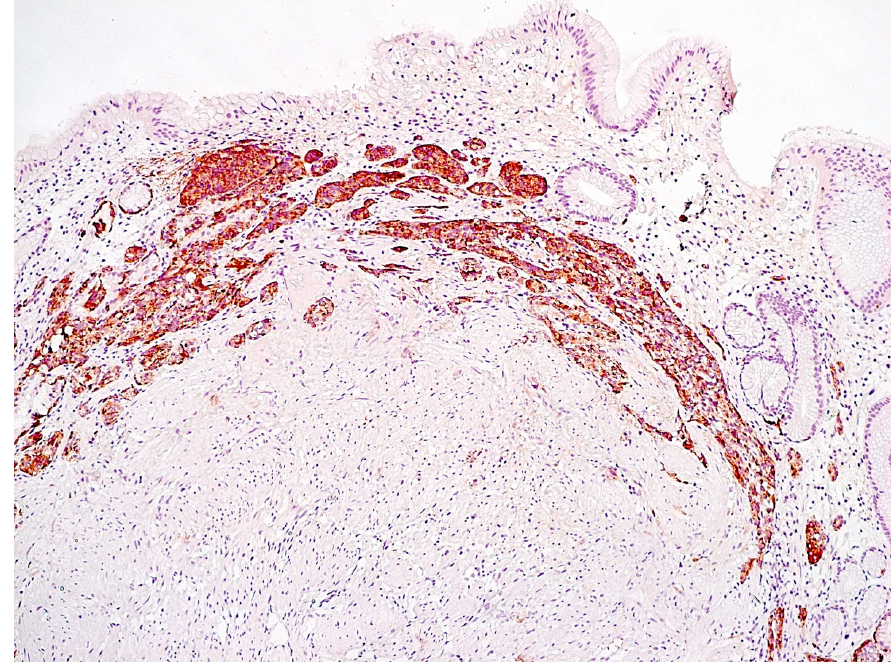
Figure 5. Autoimmune gastritis. Biopsy from the gastric body. Severe atrophy of the glands with pseudopyloric metapla- sia. Adenomatous hyperplasia of neuroendocrine cells with the presence of cluster aggregates. Immunohistochemical re- action with antibodies to chromogranin A. ×100 (from the personal archive of Professor S.I.